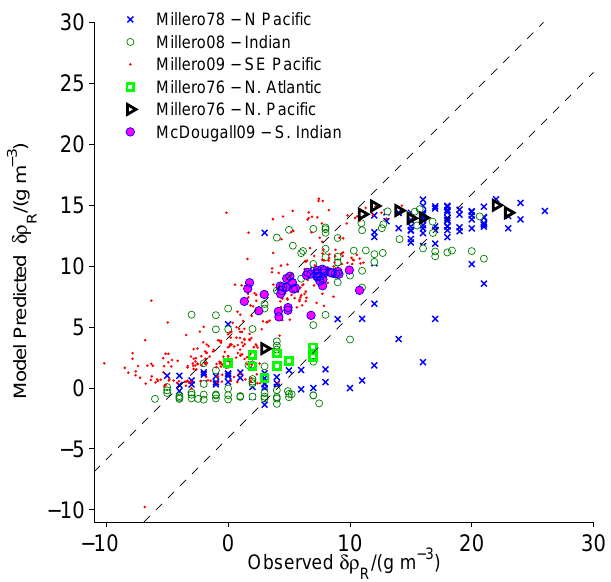
Fig. 8. Comparison between direct ocean observations of δρ R and model estimates based on measurements of conductivity, nutrients, and carbonate system parameters. The dashed lines show relation- ships δρ R ( model ) = δρ R ( observed ) ± 0.004g m − 3